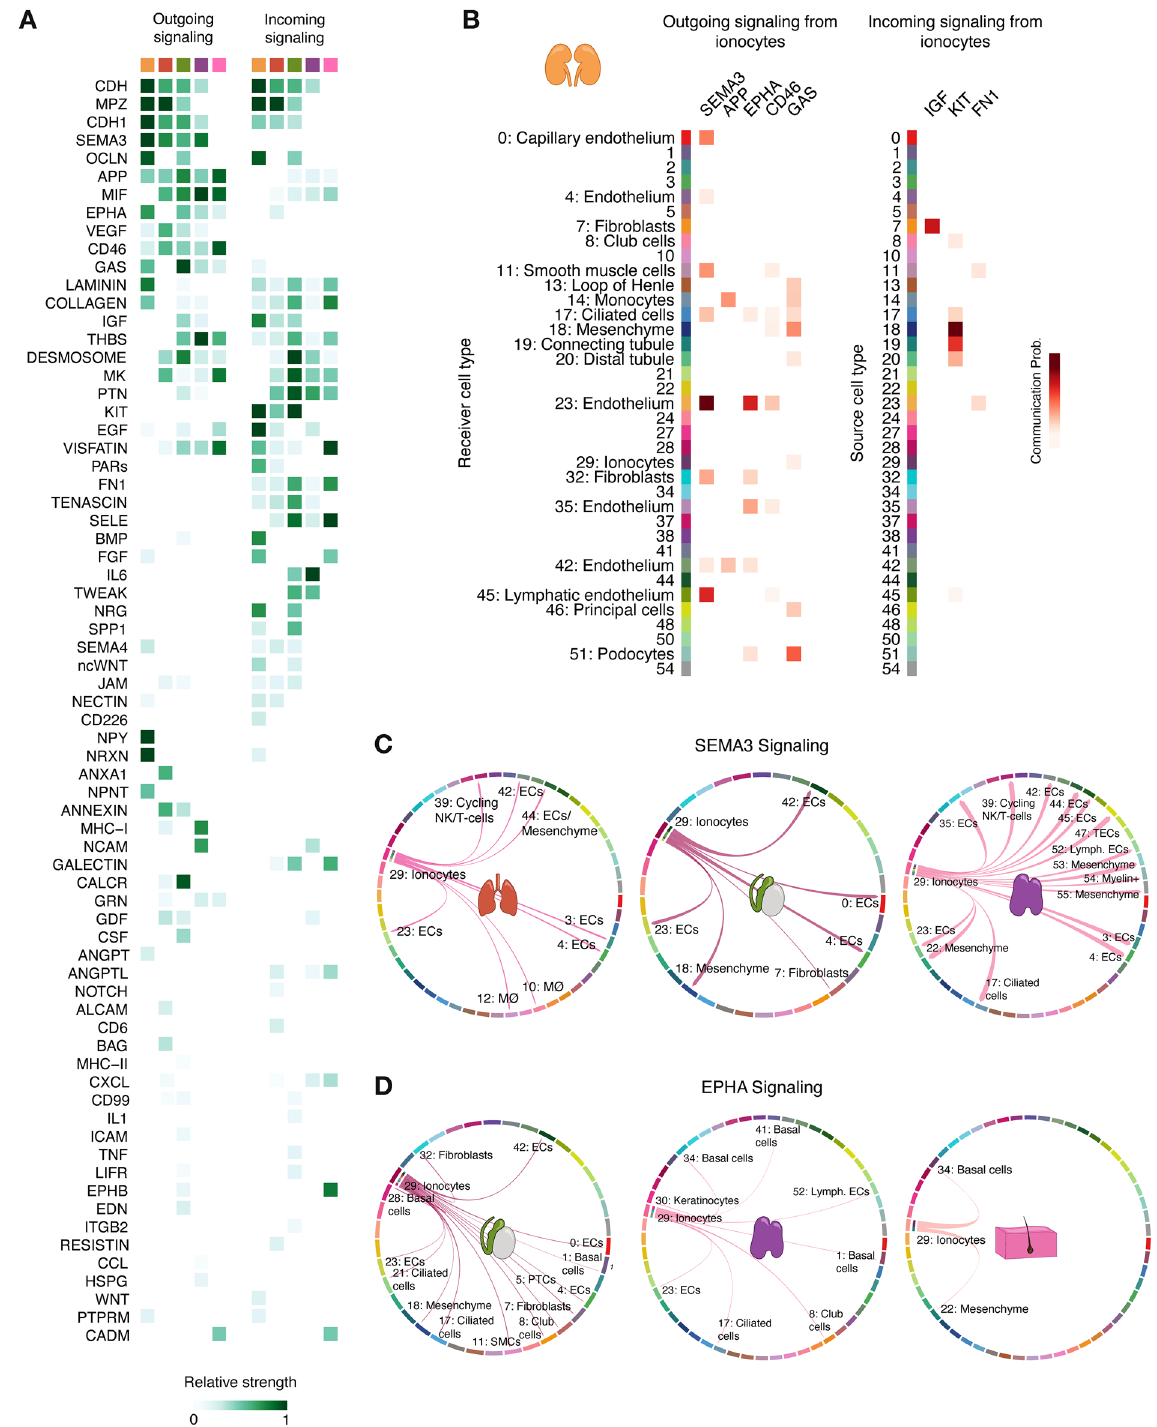
Figure 4. Main outgoing and incoming signaling in human ionocytes. ( A ) Heatmap showing the list of pathways identified as relevant outgoing or incoming signals in human ionocytes derived from different organs (orange: kidney, red: airway, green: epididymis, purple: thymus, pink: skin). ( B ) Heatmap depicting examples of probable communications between kidney ionocytes and other cell types through different pathways. Examples of communications between ionocyte populations from other organs and other cell types based on the signaling pathways semaphorin 3 (SEMA3) ( C ) and ephrin-A (EPHA) ( D ) can be seen as chord